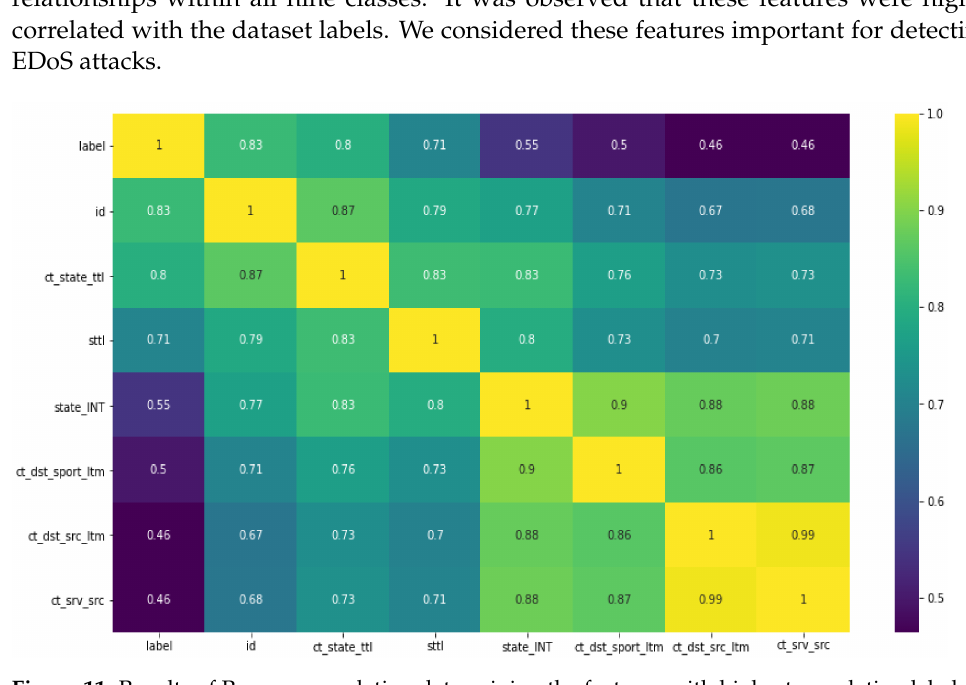
Figure 11. Results of Pearson correlation determining the features with highest correlation